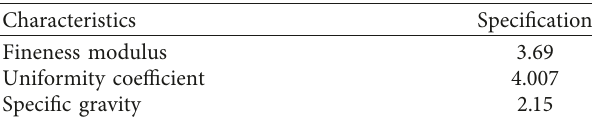
Table 3: Properties of river sand.